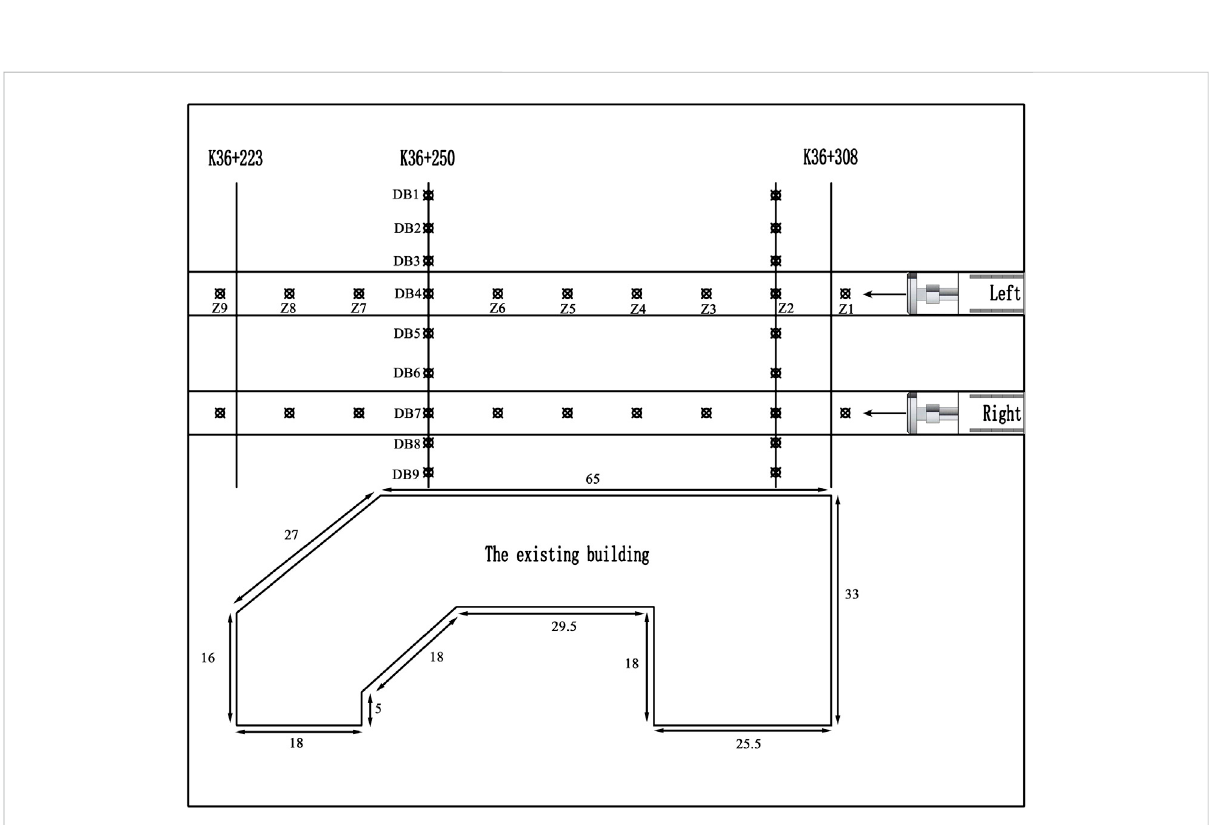
FIGURE 2 Layout of monitoring points in the underpass area of the Zhongcong